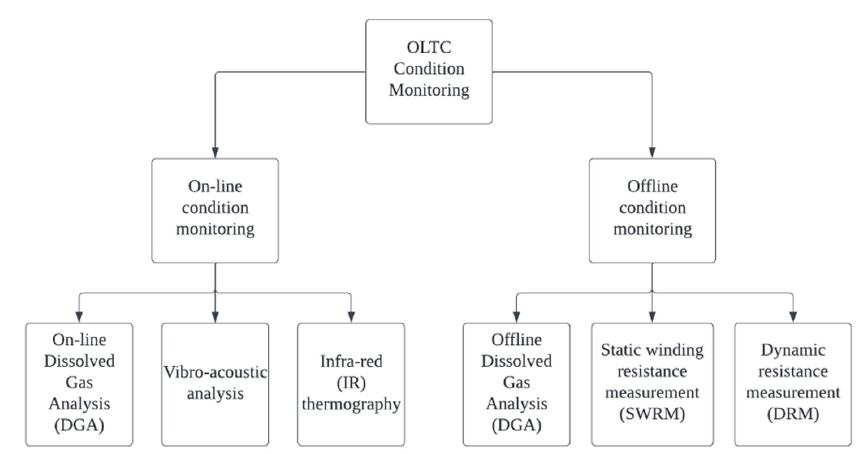
Figure 10. On ‐ load tap changer (OLTC) monitoring techniques